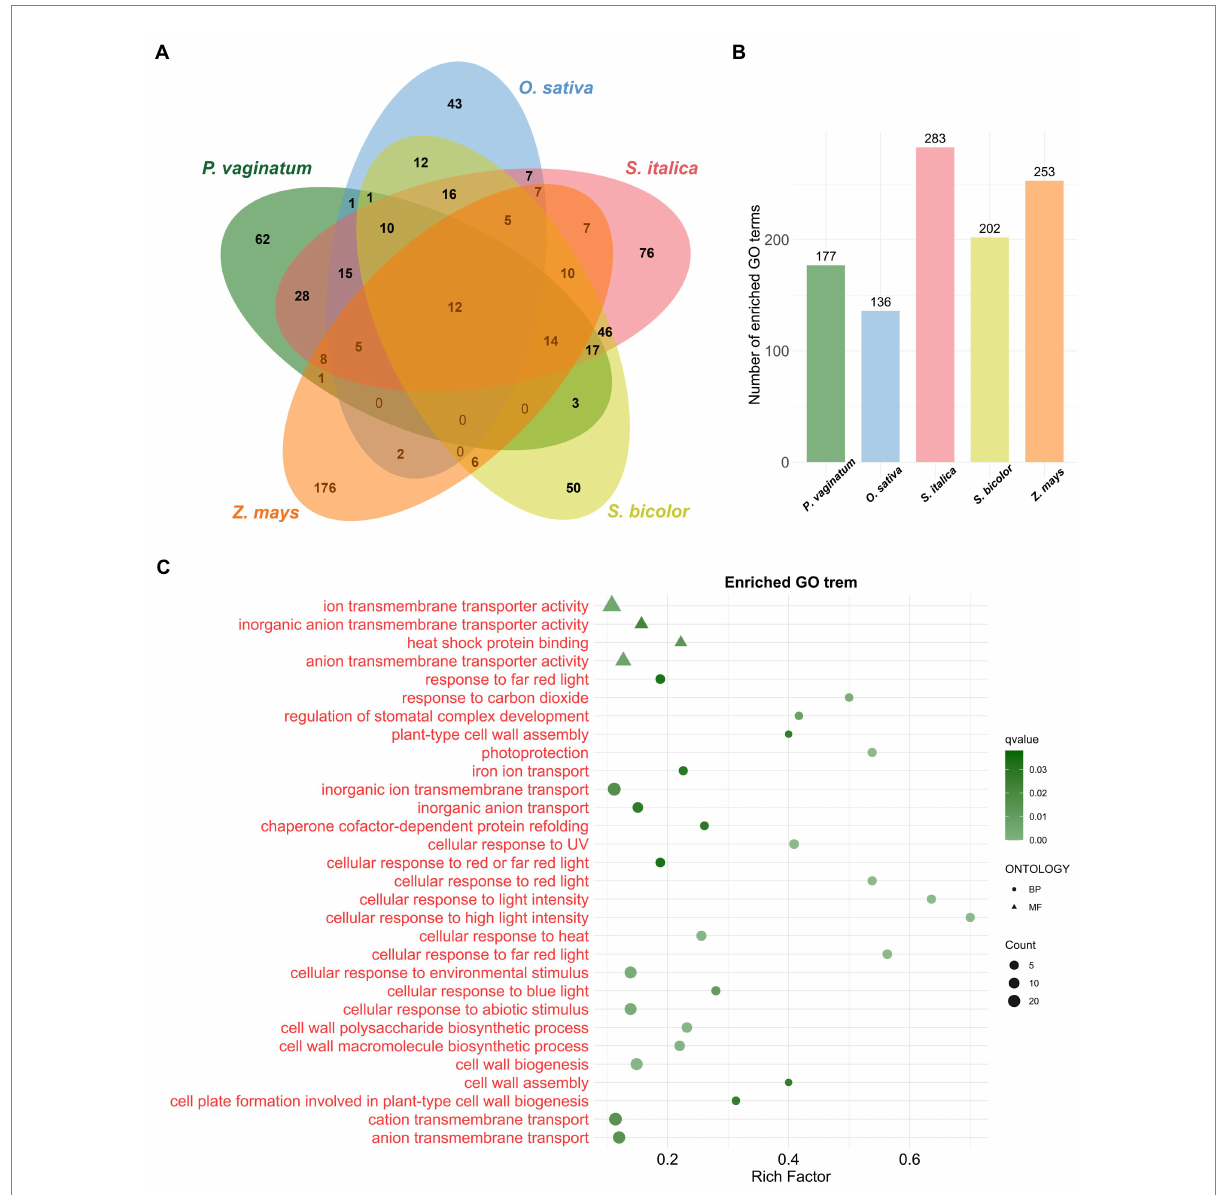
FIGURE 2 GO enrichment analysis of TDGs. (A) The venn diagram represents the shared and unique enriched GO terms among five species. (B) The size of enriched GO terms in each species. (C) The bubble diagram shows 30 significantly enriched GO terms. The terms in red are unique to P. vaginatum compared to the other four